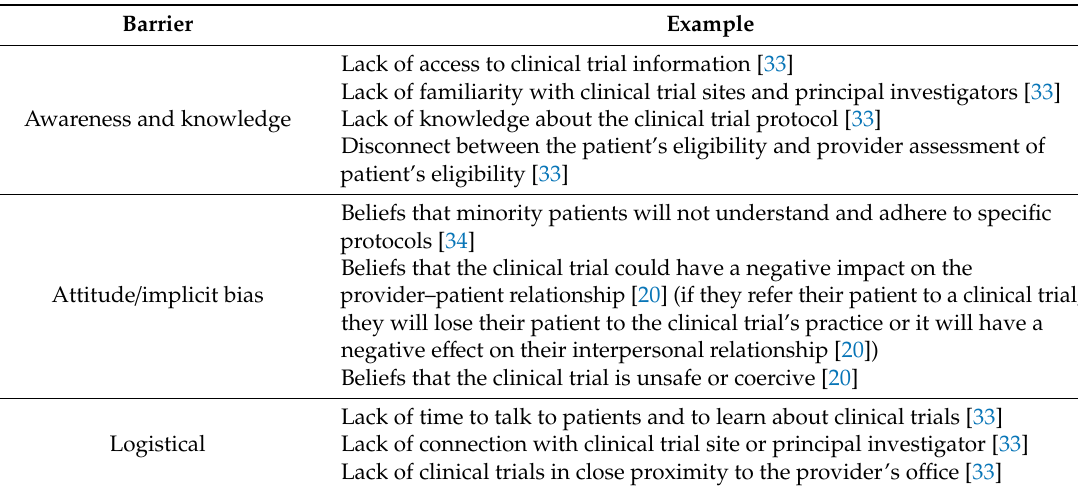
Table 2. Provider-side clinical trial recruitment